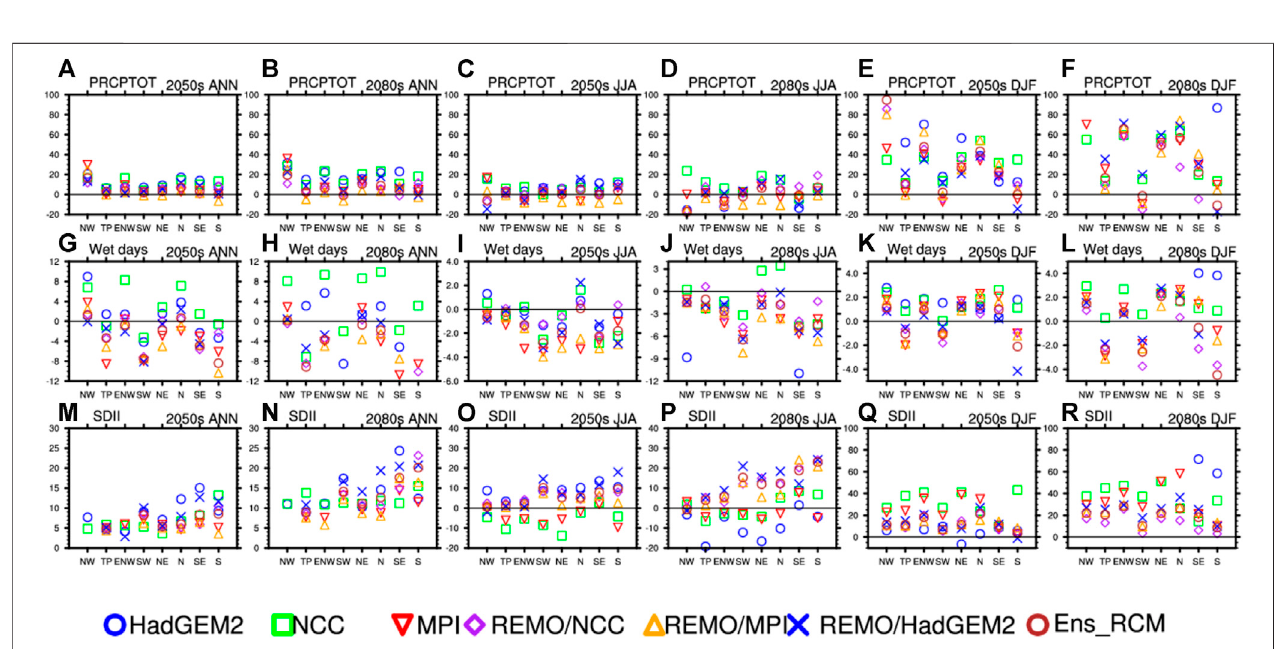
FIGURE 7 | The future changes of annual (ANN), summer (JJA) and winter (DJF) precipitation, precipitation intensity and number of wet days in each model during 2036 – 2065 and 2066 – 2095.